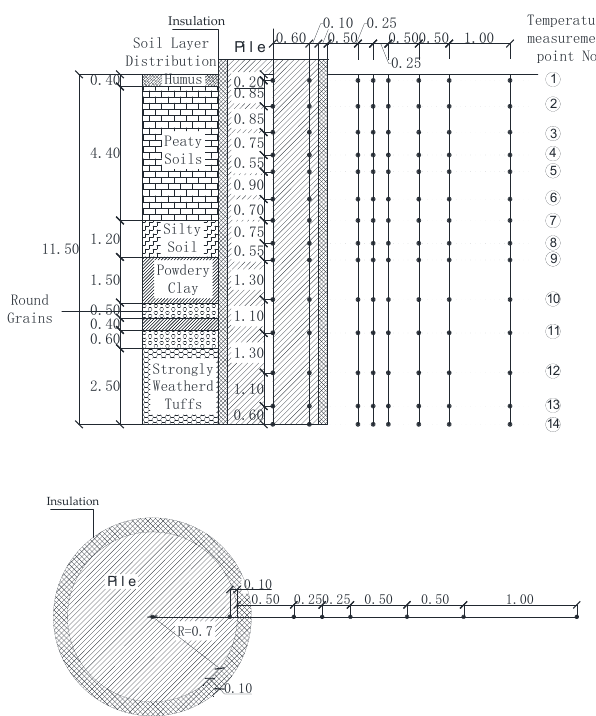
Figure 2. 2# test pile temperature measurement point layout diagram.